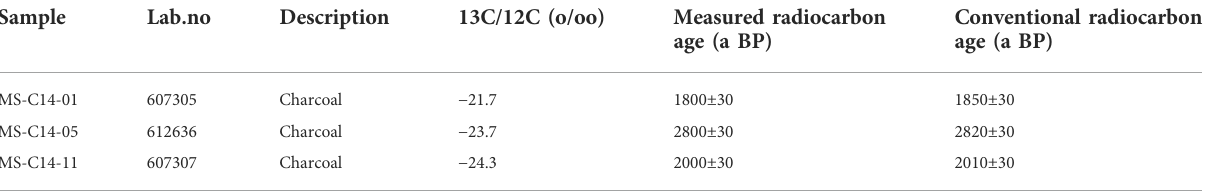
TABLE 1 Radiocarbon ages of the samples collected along the Maisu